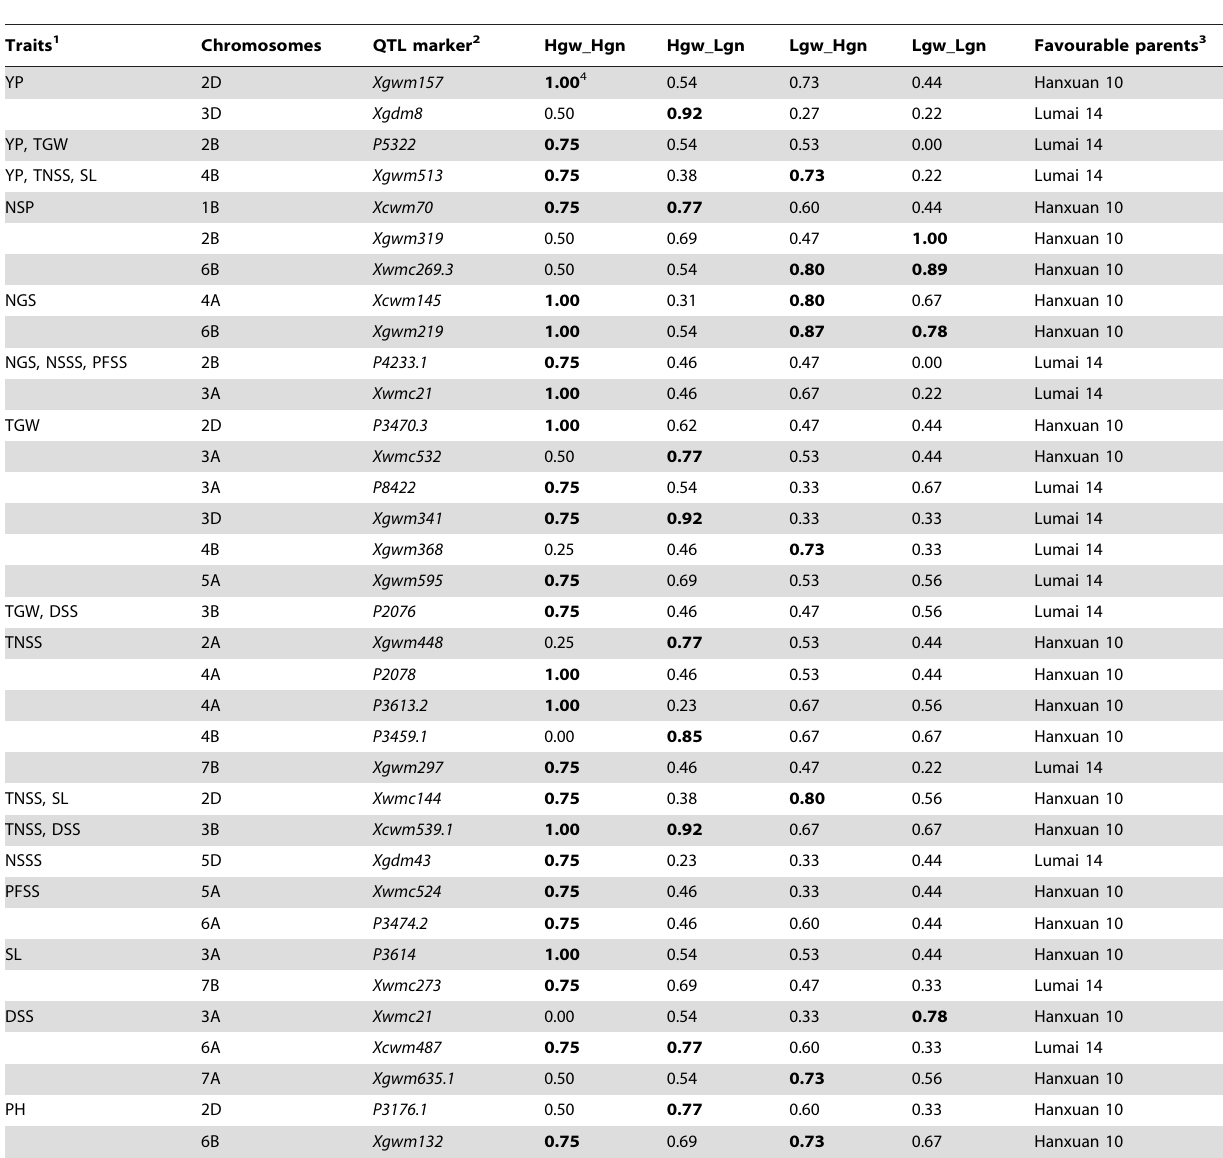
Table 10. Favorable allele frequencies of the additive main QTLs for yield and yield-related traits in four 1000 grain weight (gw) - grain number per spike (gn) groups of wheat DH